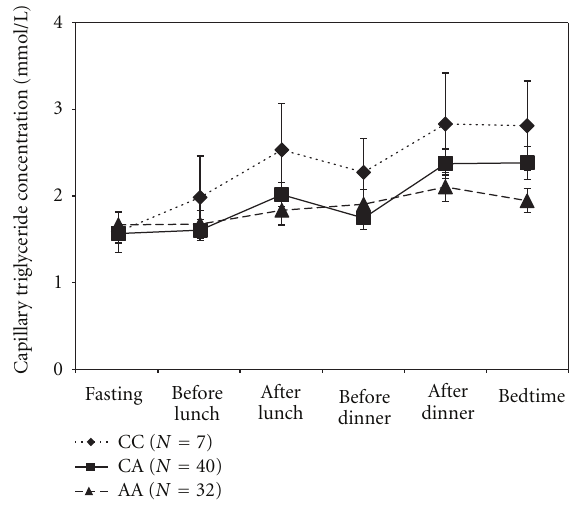
Figure 1: Diurnal capillary triglyceride (cTG) patterns for A1166C polymorphisms. Fasting cTG was similar for the three di ff erent polymorphisms, but homozygous carriers of the 1166-C allele showed a significantly increased incremental area under the cap- illary triglyceride curve compared to homozygous carriers of the 1166-A allele ( P < 0 . 05).